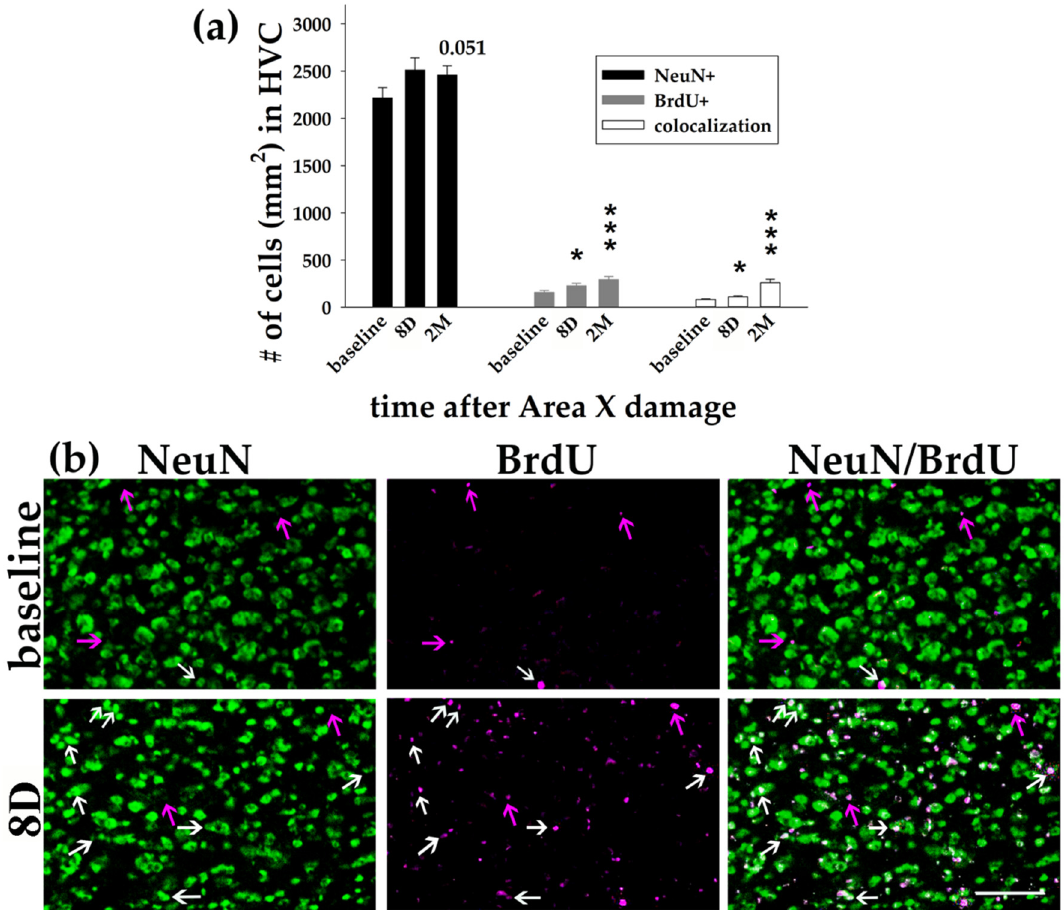
Figure 4. Neurons and newborn cells/neurons in the song nucleus HVC. ( a ) Quantification of the NeuN+ neurons, BrdU+ cells, and their co-localization in HVC of baseline birds, at 8D and 2M after Area X lesion. Each bar represents mean and SEM. T -tests for comparisons to the baseline. * p < 0.05, *** p < 0.001. ( b ) Examples of immunohistochemical staining showing NeuN (green) and BrdU (magenta) in a baseline bird (upper row) and a bird 8D after Area X lesion (bottom row). The white arrows point to the new BrdU+/NeuN+ neurons, the magenta arrows point to BrdU+ cells. The scale bar represents 50 μ m.